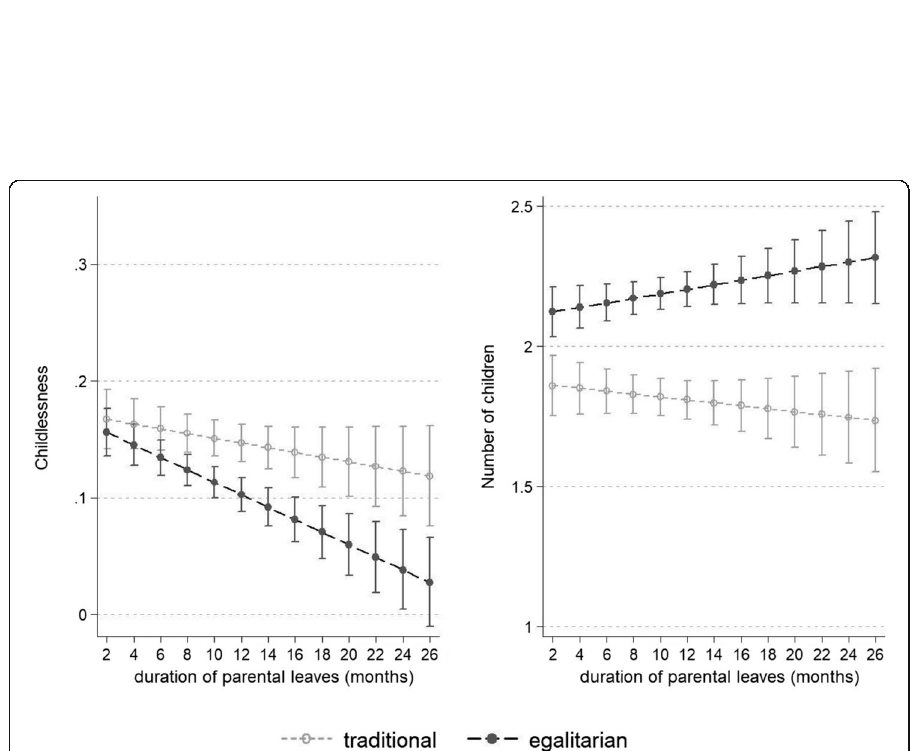
Fig. 4 Predicted probabilities of being without children (left panel) and predicted number of children (right panel) by parental leaves duration and different levels of gender egalitarianism. Source : EU-LFS 2005-2010, author ’ s elaboration. Note : Predictions refer to Table 10 and Table 11 in the Appendix, models C4a and N4a. 90% confidence intervals